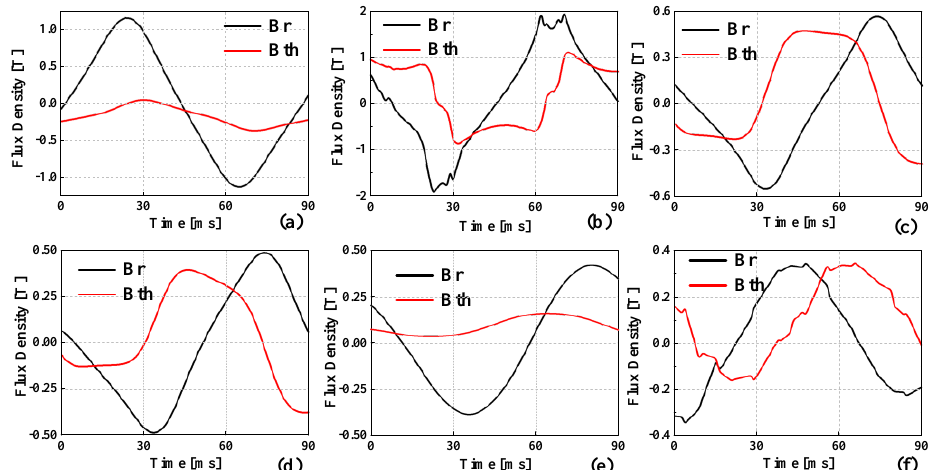
Figure 4. Segmentation analysis of core area.